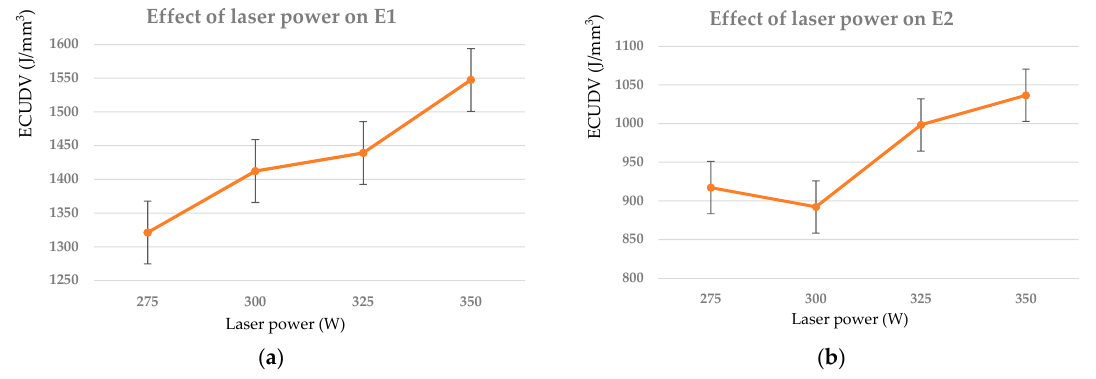
Figure 3. Effect of laser power: ( a ) theoretical value and ( b ) actual value. Powder: Inconel 718.